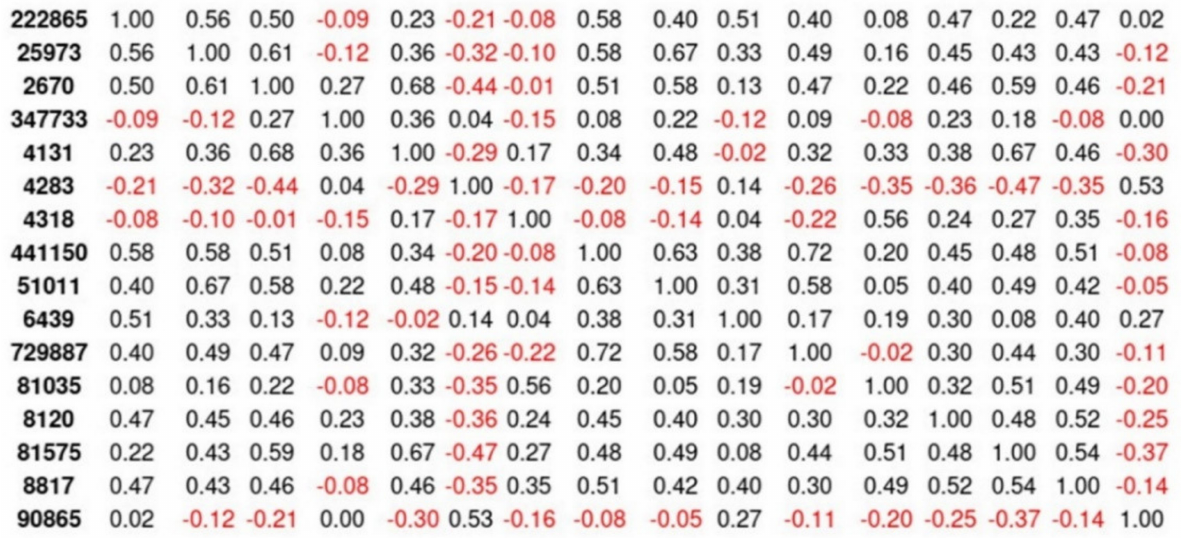
Figure 10. Pearson Correlation among features. All the features with negative correlation values are marked red, whereas positive correlations are